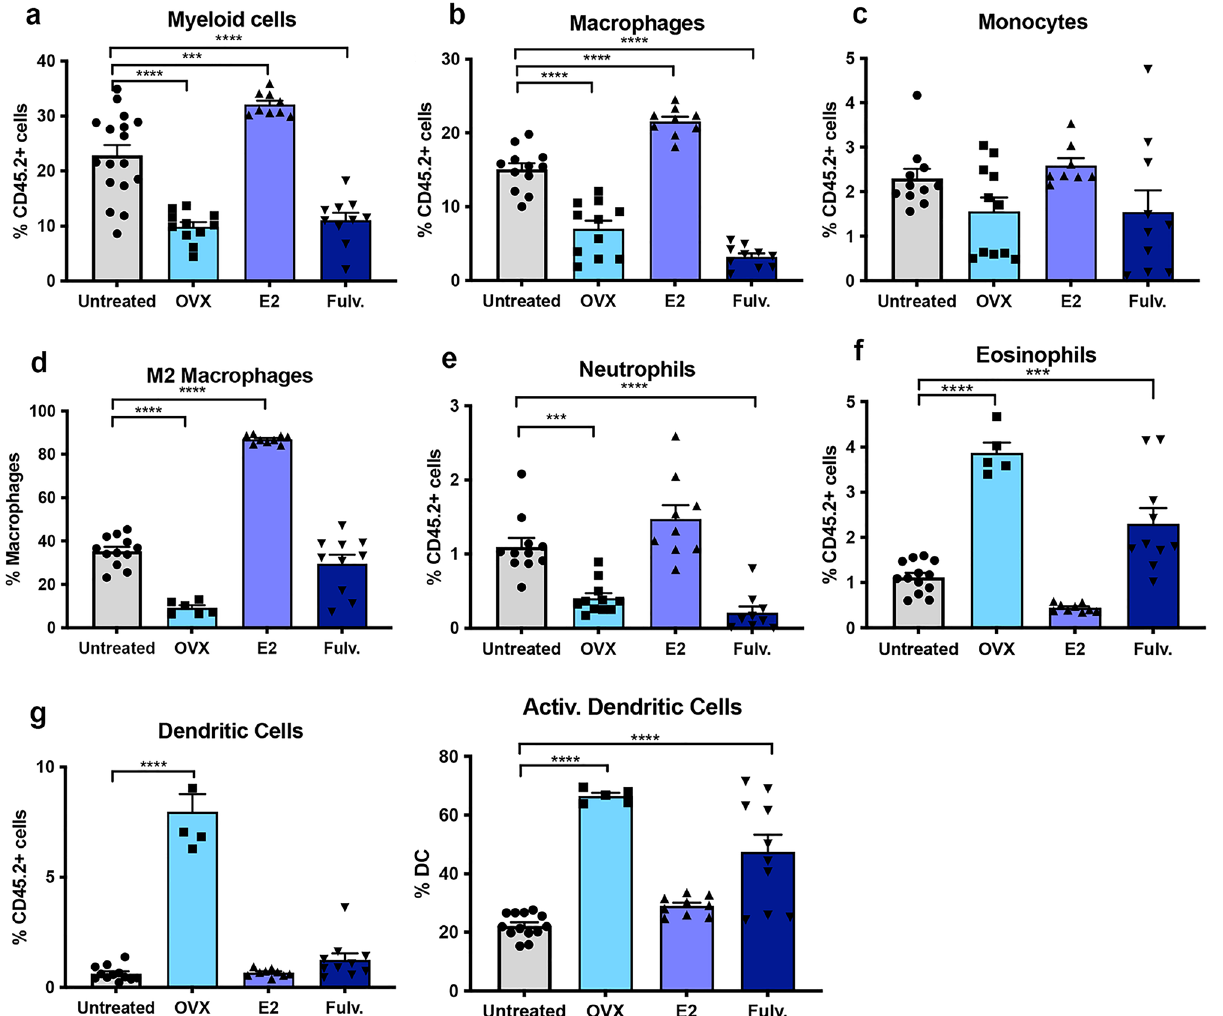
Figure 1. Effects of estrogen, oophorectomy and fulvestrant on the innate immune cells within the non- neoplastic mouse mammary gland. Mice were either untreated, ovariectomised (Ooph) or treated for 6 weeks with estrogen (E2) or Fulvestrant (Fulv). ( a ) Myeloid cells, ( b ) macrophages, ( c ) monocytes, ( d ) M2 macrophages, ( e ) neutrophils, ( f ) eosinophils, ( g ) dendritic cells. Results are expressed percentage of immune cells (mean ± SEM). n = 11–17 mice/group. Data was analysed using a Turkey multiple comparisons one-way ANOVA if confirmed Gaussian distribution, or Kruskal–Wallis multiple comparisons 1-way ANOVA if non- Gaussian. Statistically significant results are denoted with *p < 0.05, **p < 0.01, ***p < 0.001, ****p < Estrogen effects the immune composition of intra mammary lymph nodes. Lymph nodes are important in the anti-tumour response as naive T cells interact with antigen presenting cells (APCs) to generate T cell-dependent immune responses. The lymph nodes showed some changes, mainly with estrogen, but not with oophorectomy or fulvestrant. Analysis of the myeloid compartment of the inguinal lymph node revealed that estrogen did not affect the overall frequency of lymph node associated macrophages (Fig. 3a), but it did selectively increase the proportion of CD206 + macrophages (Fig. 3b). Oophorectomy increased in the propor- tion of macrophages but the CD206 + M2 macrophages remained unchanged (Fig. 3a–b). Fulvestrant did not change the macrophage populations. Estrogen led to a reduction in the total DC frequency, as well as activated DCs (Fig. 3c,d), but oophorectomy and fulvestrant did not impact them. Within the adaptive immune system, estrogen led to lower levels of T cells in the lymph node, but did not alter the proportion of B cells. Oophorectomy and fulvestrant did not alter them (Fig. 4a–b). CD4 T cells were decreased by estrogen but total CD8s were not impacted (Fig. 4c–d). Oophorectomy and fulvestrant did not impact the lymph node CD4 and CD8 T cells. Estrogen did not impact the proportion of activated CD4 or CD8 T cells (Fig. 4e–f) but fulvestrant increased the number of activated CD69 + CD8 T cells (Fig. 4f). Estrogen increased the proportion of CD4 central memory effector cells and decreased CD8 central memory effectors (Fig. 4g–h). Oophorectomy increased the CD4 central memory CD4 T cells. Oophorectomy increased the proportion central memory CD8 + T cells, and naïve CD8 + T cells (Fig. 4h). Estrogen led to increased CD8